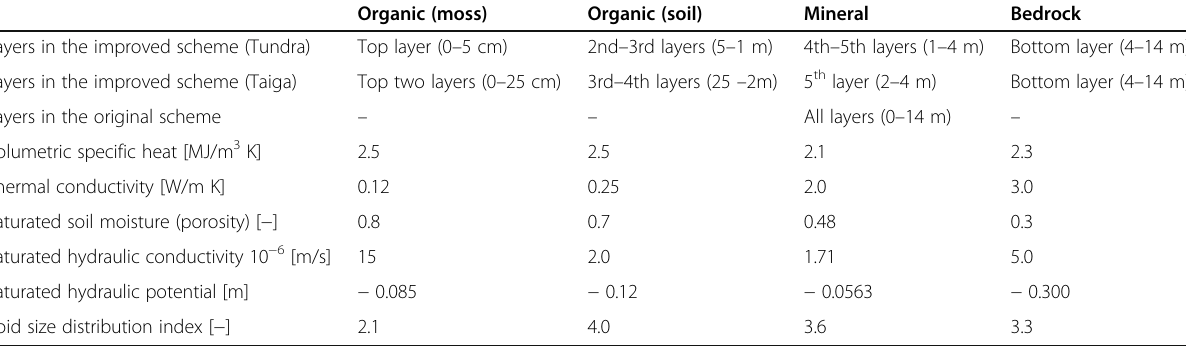
Table 1 Parameter values for the organic, mineral soil, and base layers used in the improved scheme. The values for the mineral layers are dependent on the soil type. Here, the values of the mineral layers for the “ sand ” soil type are shown. The layers for the organic (moss and soil), mineral soil, and bed lock layer for the improved and conventional schemes are also shown Organic (moss)